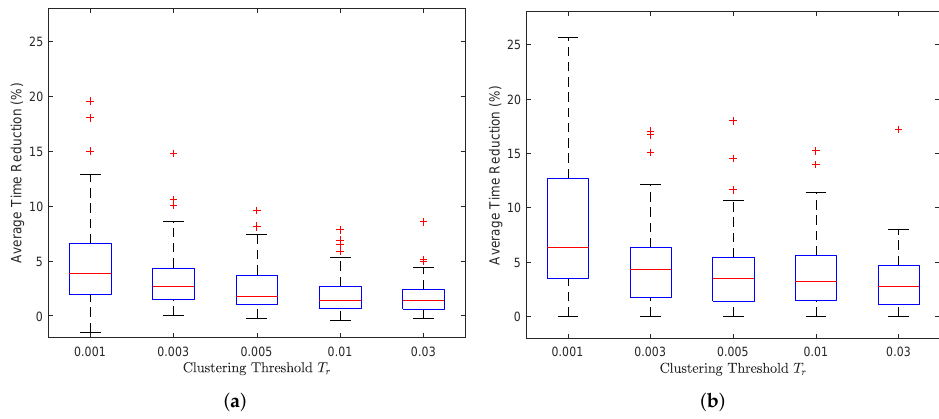
Figure 11. Time reduction via line position encoding and cascade matching strategies. ( a ) Time reduction for the CVC dataset, ( b ) Time reduction for the VIS